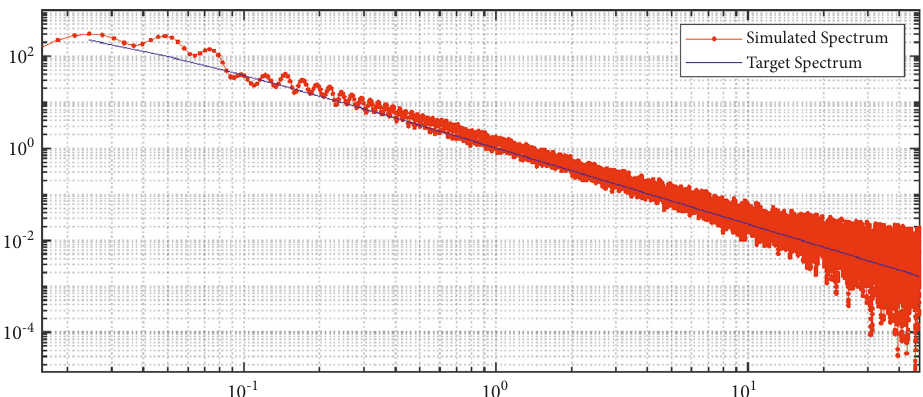
Figure 6: Power spectral comparison at the top of the tower, V